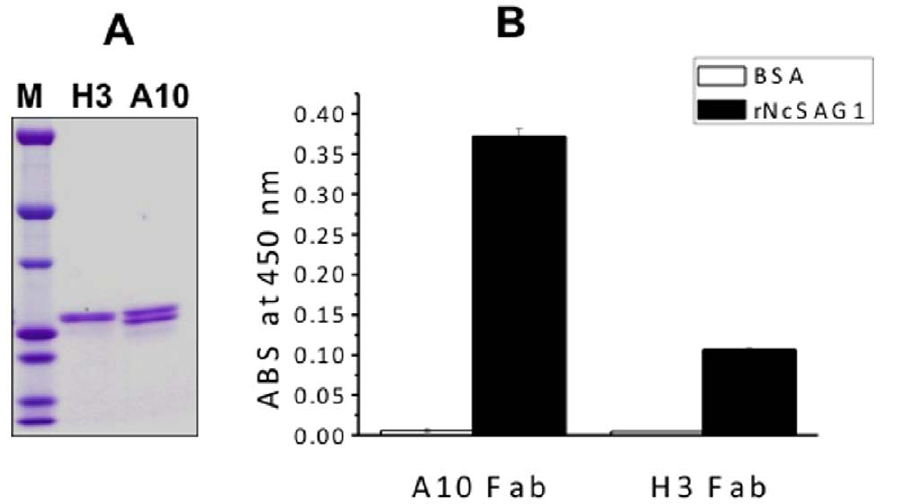
Figure 3. Purification of Fab antibodies and binding assays to rNcSAG1. SDS-polyacrylamide gel electrophoresis analysis of purified Fab antibodies (A) and the binding of A10 and H3 to rNcSAG1 proteins (B). M: Precision Plus Protein TM Dual Colors Standards. Anti-Nc ab: anti- Neospora caninum antibody.